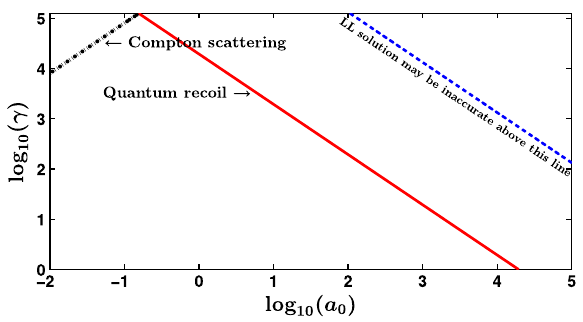
FIG. 17. The log 10 ð γ Þ vs log 10 ð a 0 Þ plot of the regions of validity for the relativistic electron in a counterpropagating laser beam with ω ¼ 2 × 10 15 s − 1 and u z =c ≈ 1 . Above the solid red line, quantum recoil effects of the emitted photons may be significant. Above the dotted black line, quantum Compton scattering of the individual incident photons may be significant. Above the dashed blue line, the LL solution may not be an accurate approximation to the LAD